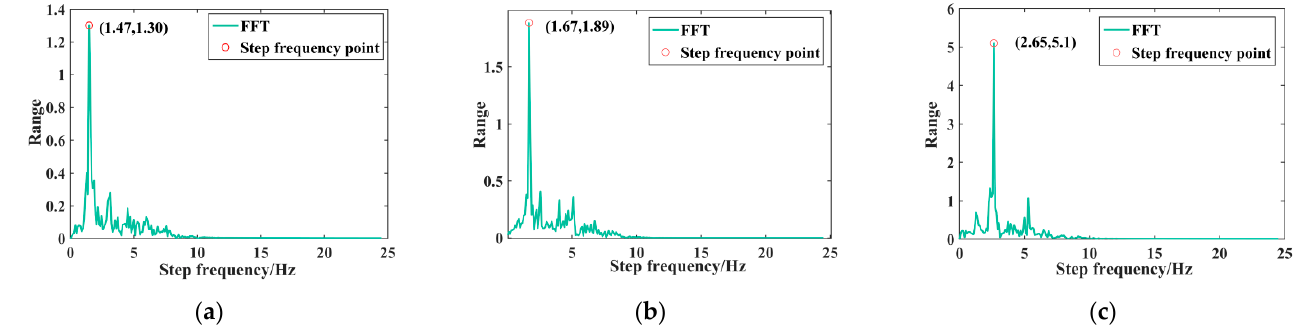
Figure 5. Spectrum of pedestrian stroll walking, normal walking and running: ( a ) Stroll walking ( b ) Normal walking ( c ) Running. Table 1. Empirical values of step frequency threshold, time threshold and peak threshold.